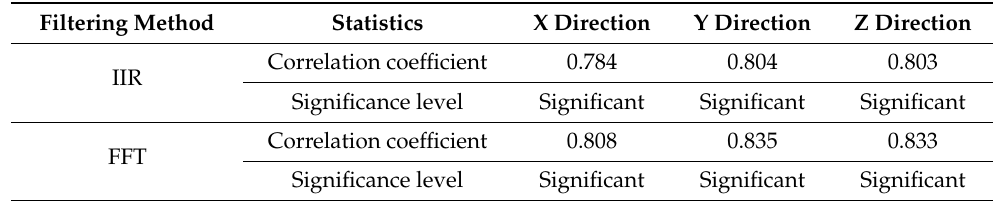
Table 2. Comparison of statistical correlations between original acceleration data and those processed by each of the IIR and FFT low-pass filtering